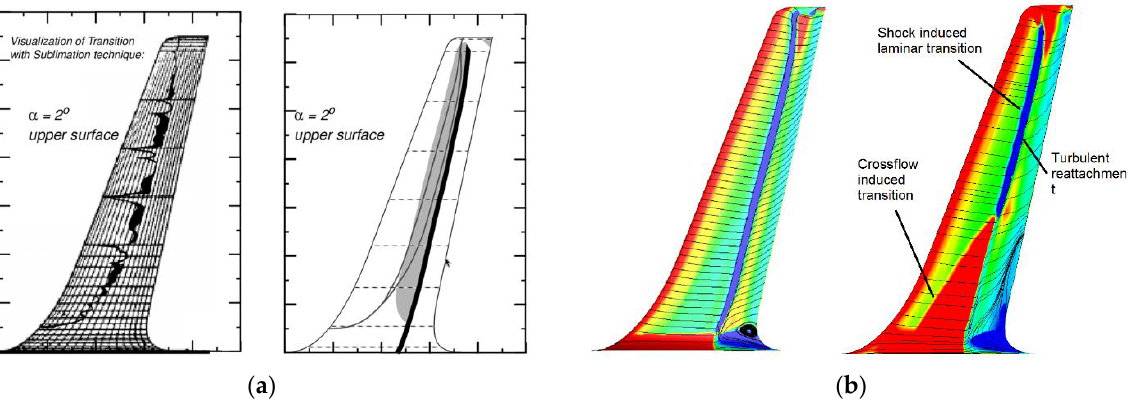
Figure 3. Comparison between DLR-F5 experimental data and simulation results. ( a ) Experiment data for the DLR-F5 wing. In the right figure, the gray shade represents the mixture of the transition and separation, the two gray thin lines represent the starting and ending of transition, respectively, and the black thick line represents the compressive area of shock wave; ( b ) Langtry – Menter and Langtry – Menter – CFH Improved numerical simulation results for DLR-F5. The contour shows the friction coefficient distribution. The blue region in the spanwise direction represents the turbulent re-attachment.